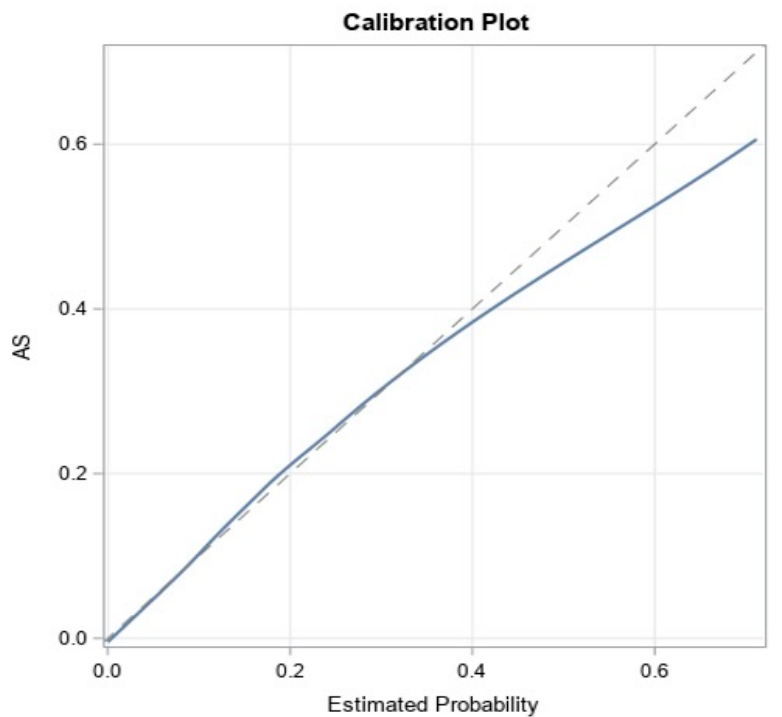
Figure 3. Calibration of the